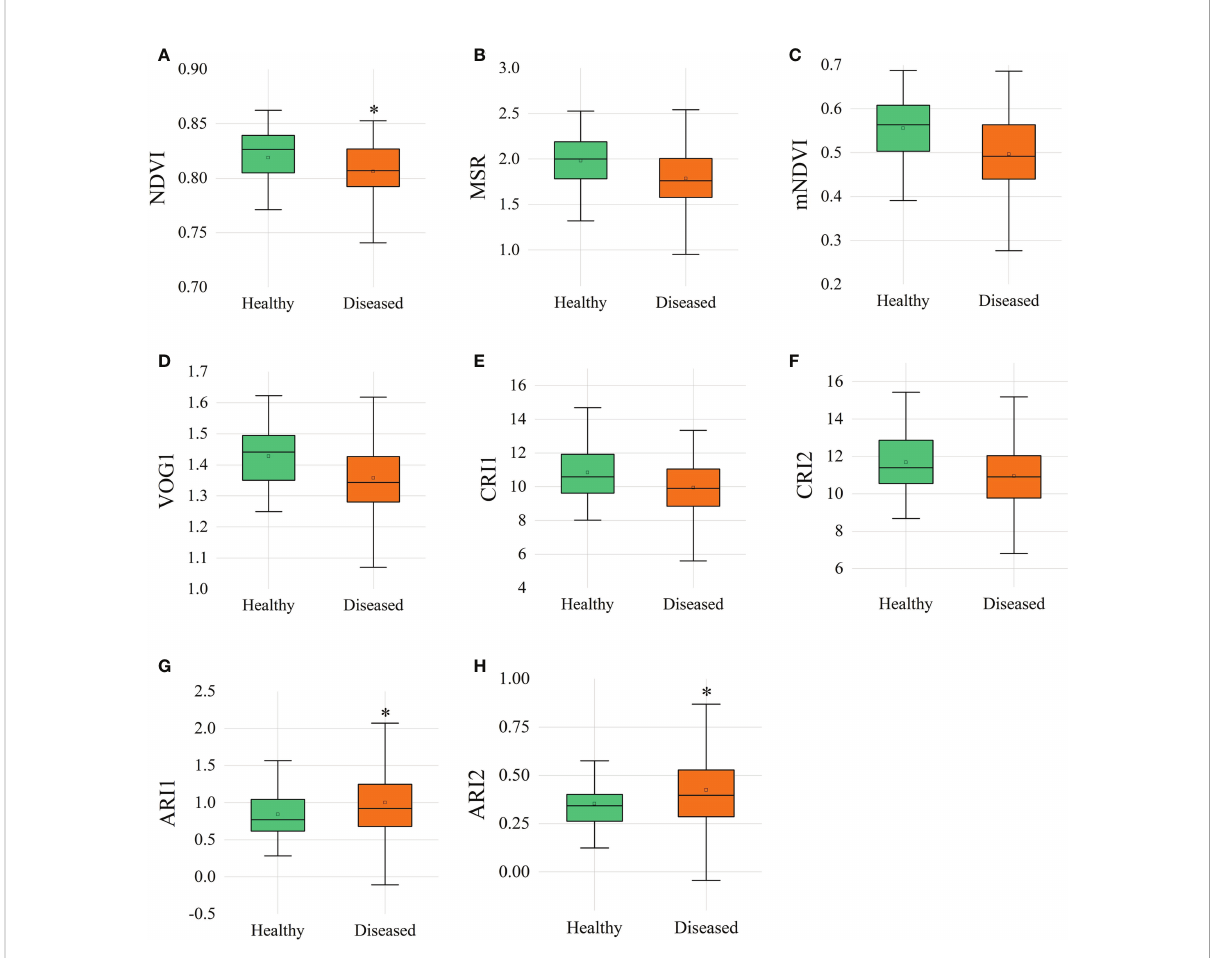
FIGURE 4 Vegetation indices of healthy and diseased ginsengs. n=57, * indicates the signi fi cant difference between healthy and diseased (P< 0.05). (A) NDVI, red edge normalized difference vegetation index; (B) MSR, modi fi ed red edge simple ratio; (C) mNDVI, modi fi ed NDVI; (D) VOG, vogelmann red edge index; (E, F) CRI, carotenoid re fl ectance index; (G, H) ARI, anthocyanin re fl ectance